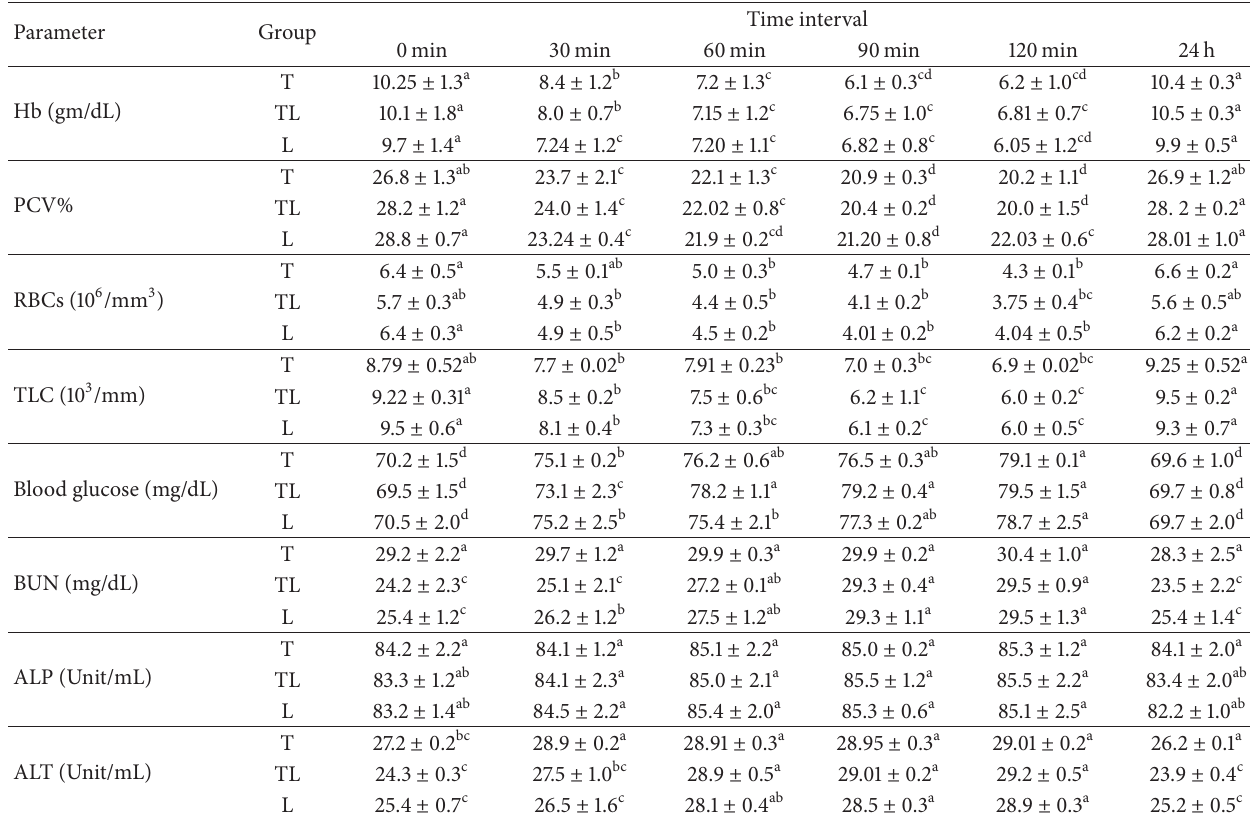
Table 2: Hematobiochemical parameters after caudal epidural administration of tramadol alone (T), tramadol-lidocaine combination (TL), and lidocaine alone (L) in buffalo calves (mean ± SD, 𝑛 = 10